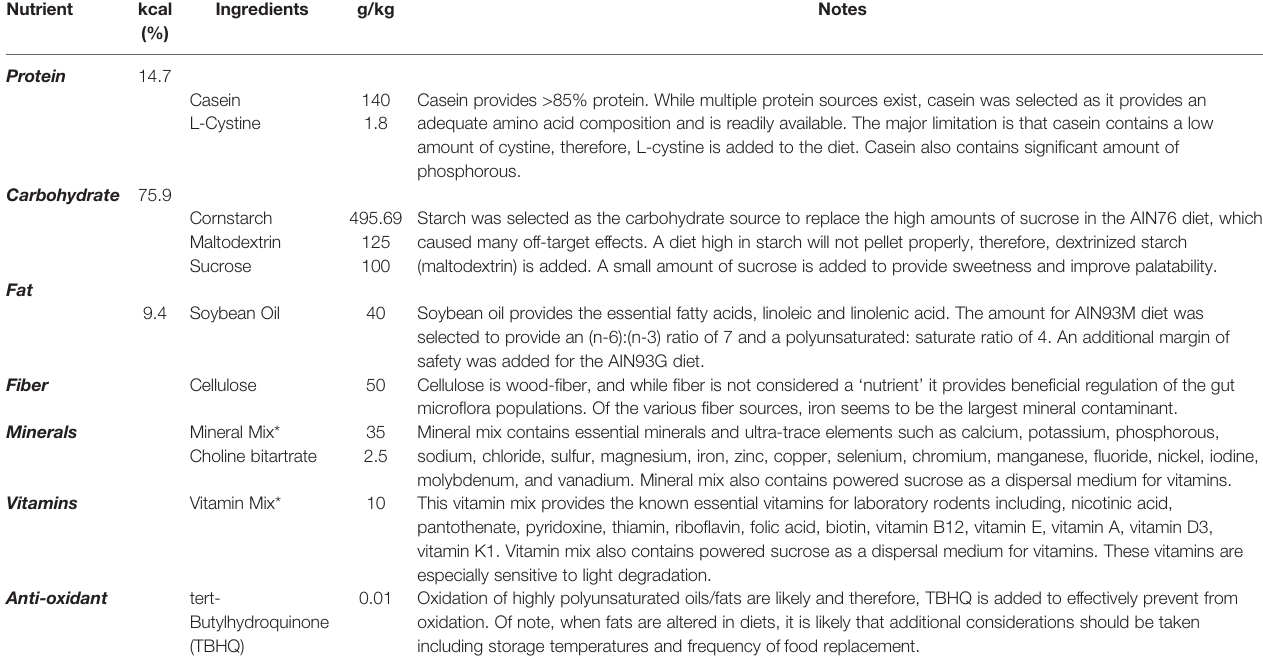
TABLE 1 | Key nutritional components and dietary formulation of the AIN-93M diet.